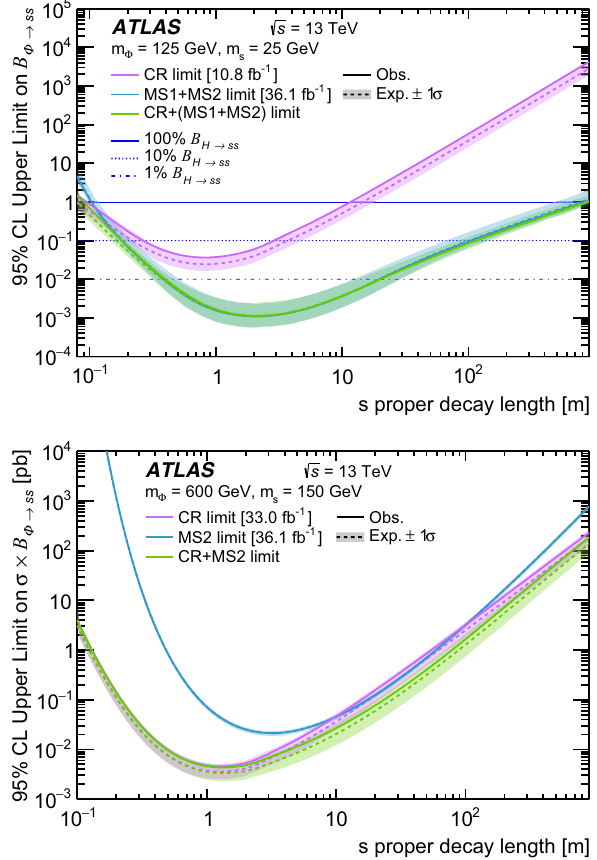
1 − 10 1 10 s proper decay length [m] Fig. 10 Examples of the combined limits for models with m (cid:4) = 125 GeV and m (cid:4) = 600 GeV from the CR analysis and the MS anal- ysis, which is separated into the MS 1-vertex plus E miss (MS1) and T MS 2-vertex (MS2) components. The MS1 component of the MS dis- placed jet search was only applied to models with m (cid:4) = 125 GeV. The expected limit is shown as a dashed line with shading for the ± 1 σ band, while the observed is a solid line. The colours of the shading and solid and dashed lines refer to the limits from each analysis and their combination, as indicated in the